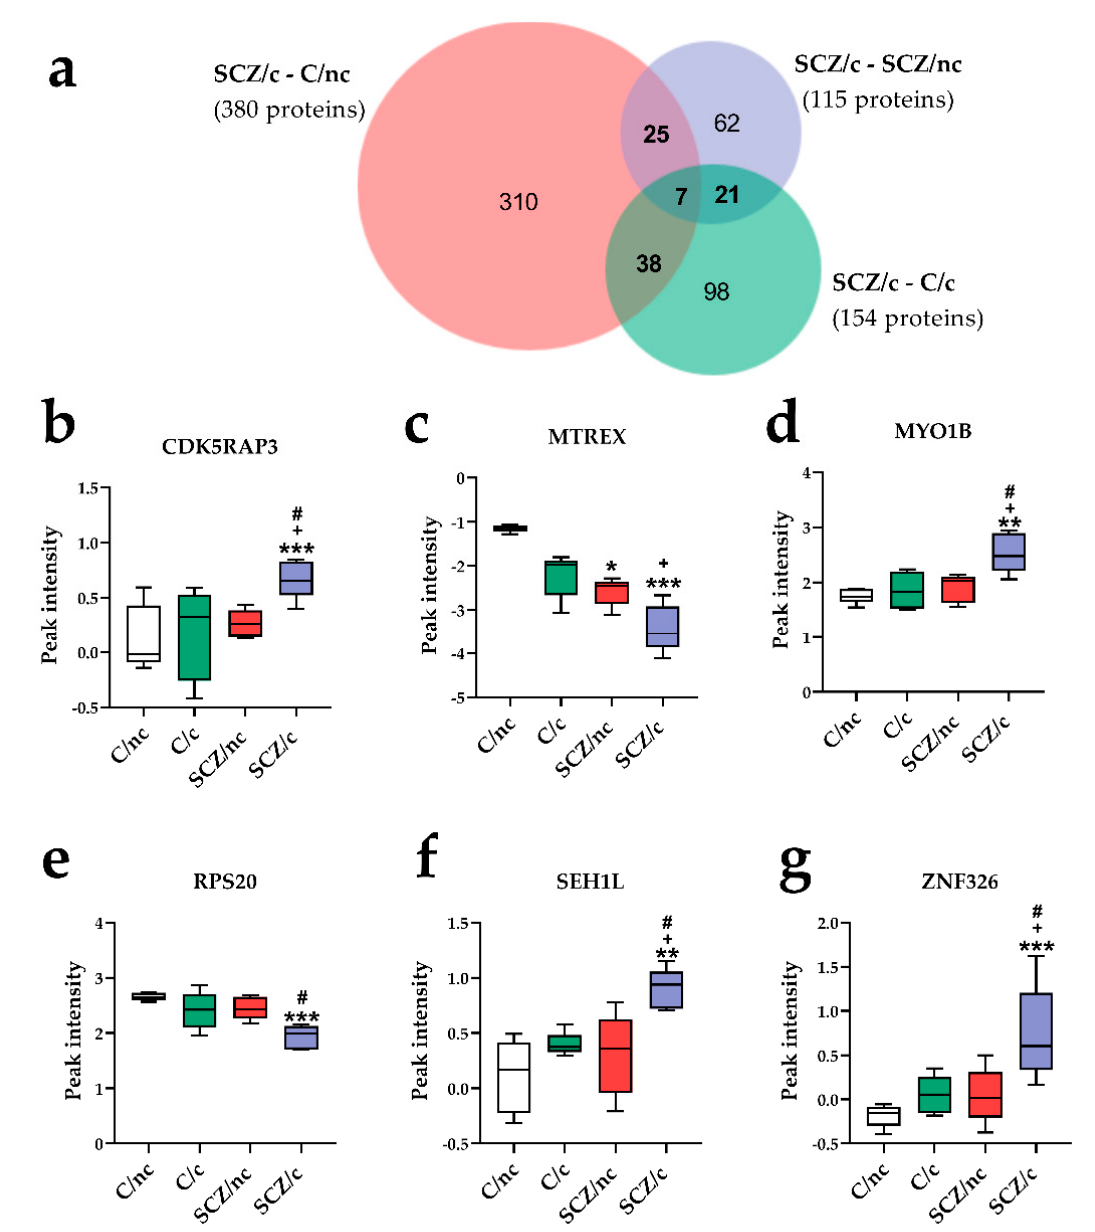
Figure 3. Specific proteome markers of schizophrenia patients cannabis users (SCZ/c). ( a ) Venn diagram comparing SCZ/c to control subjects non-cannabis users (C/nc), schizophrenia patients non-cannabis users (SCZ/nc), and control cannabis users (C/c). Graphical representation of CDK5RAP3 ( b ), MTREX ( c ), MYO1B ( d ), RPS20 ( e ), SEH1L ( f ), and ZNF326 ( g ), which were commonly deregulated in SCZ/c as compared to C/nc, C/c and SCZ/c. Data are represented as the mean ± minimum to maximum peak intensity. * p < 0.05; ** p < 0.01; *** p < 0001 versus C/nc; + p < 0.05 versus C/c; # p < 0.05; versus SCZ/nc.